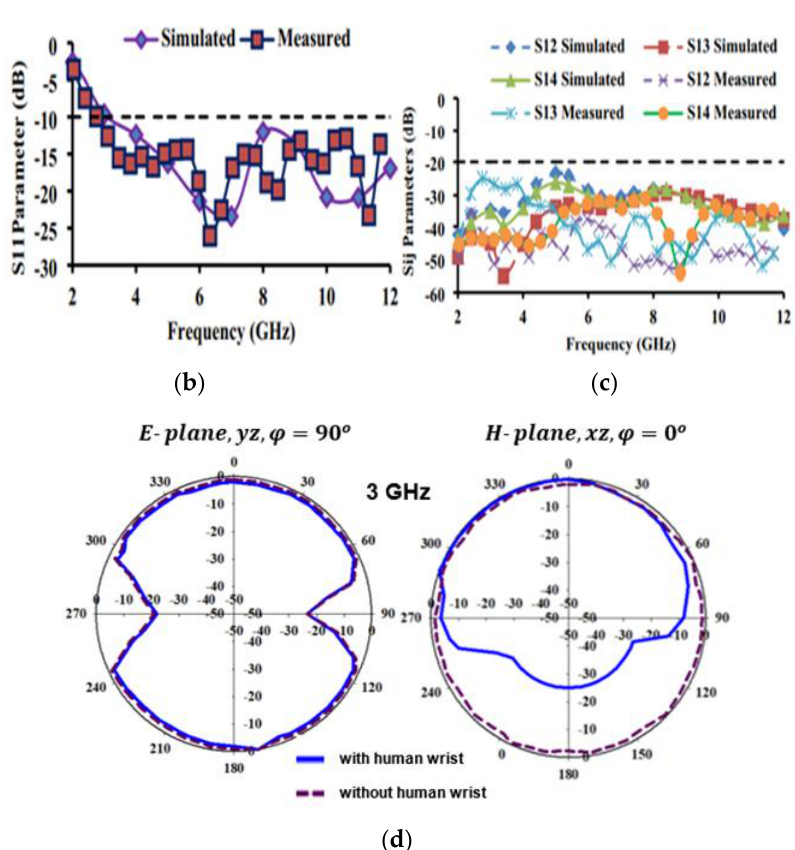
Figure 13. ( a ) The antenna layout. ( b ) S11 curves of the antenna. ( c ) Isolation curve of the antenna. ( d ) Radiation pattern. Reprinted ( a – d ) from Ref. [69].